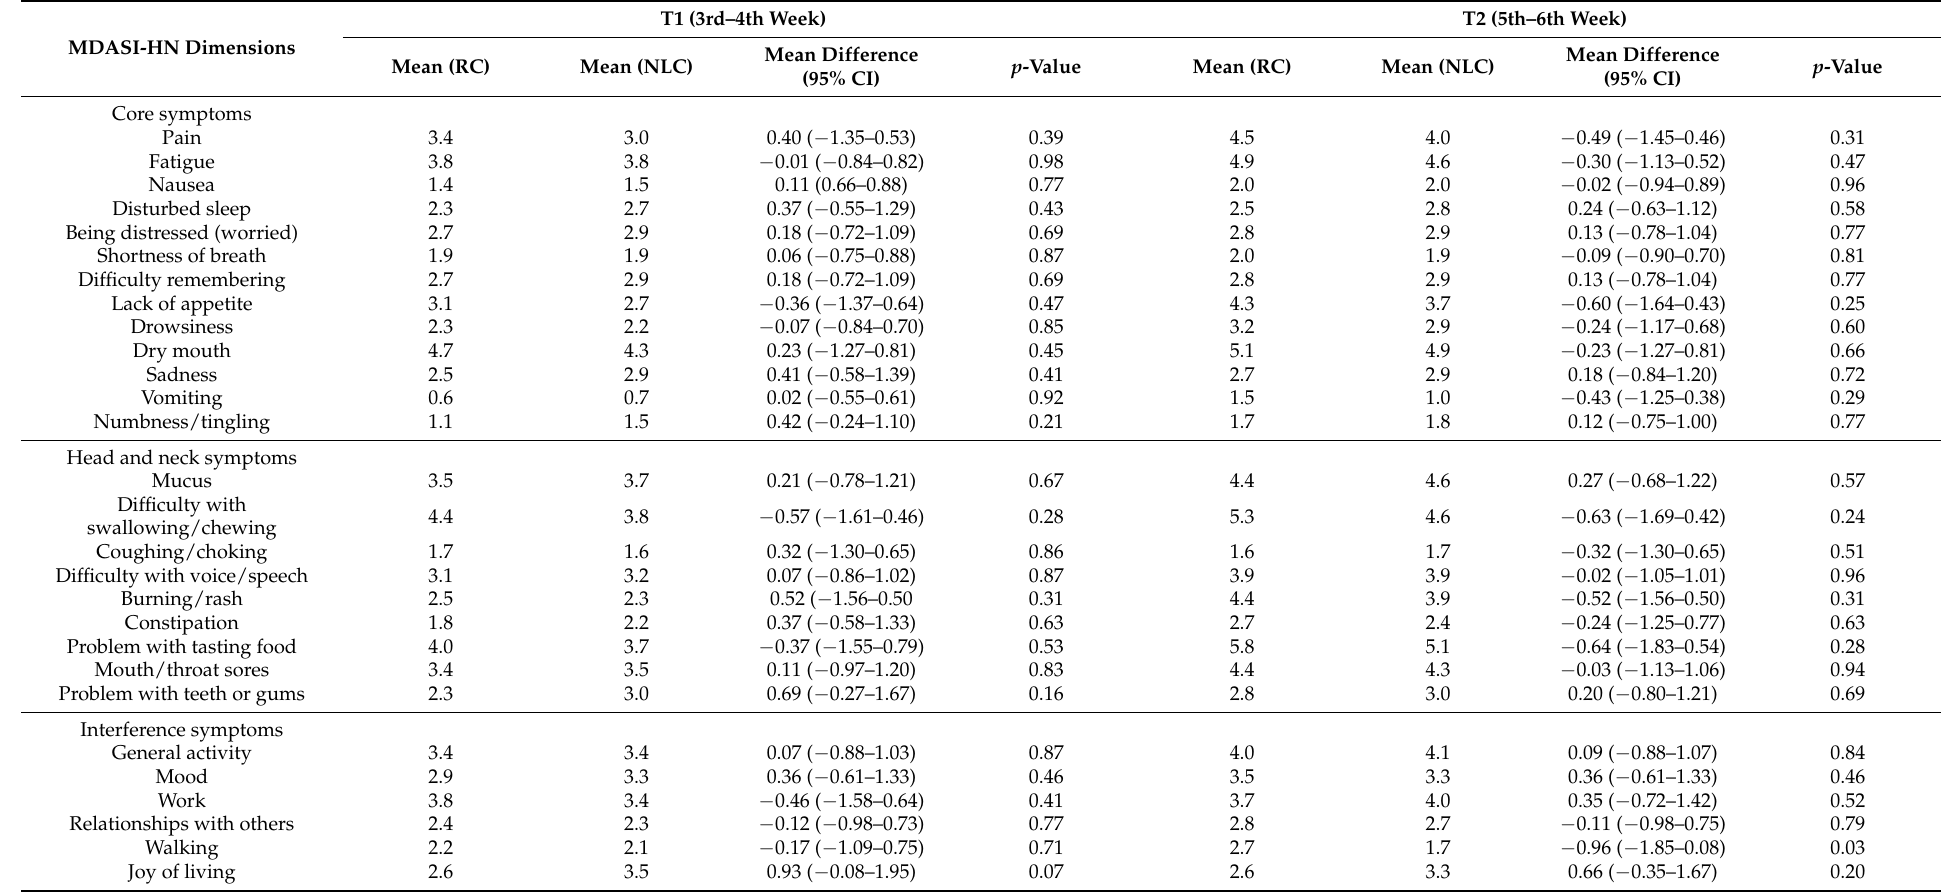
Table 4. M.D. Anderson HN mean scores and baseline-adjusted differences for routine care group (RC) and nurse-led intervention group